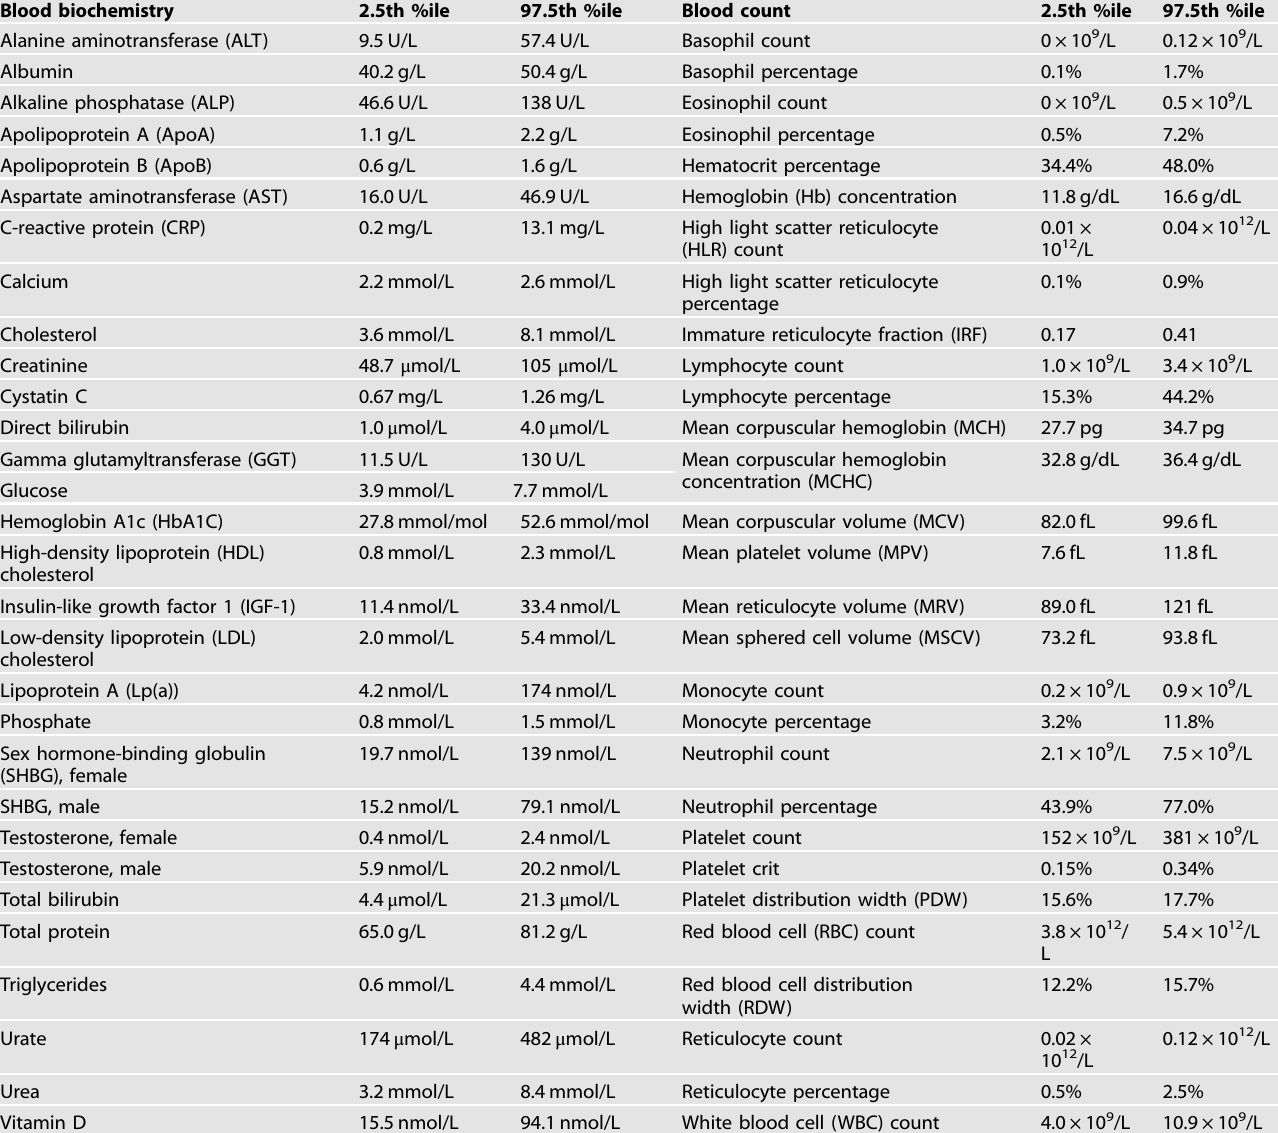
Table 1. 2.5th and 97.5th percentile thresholds for each blood test across the full